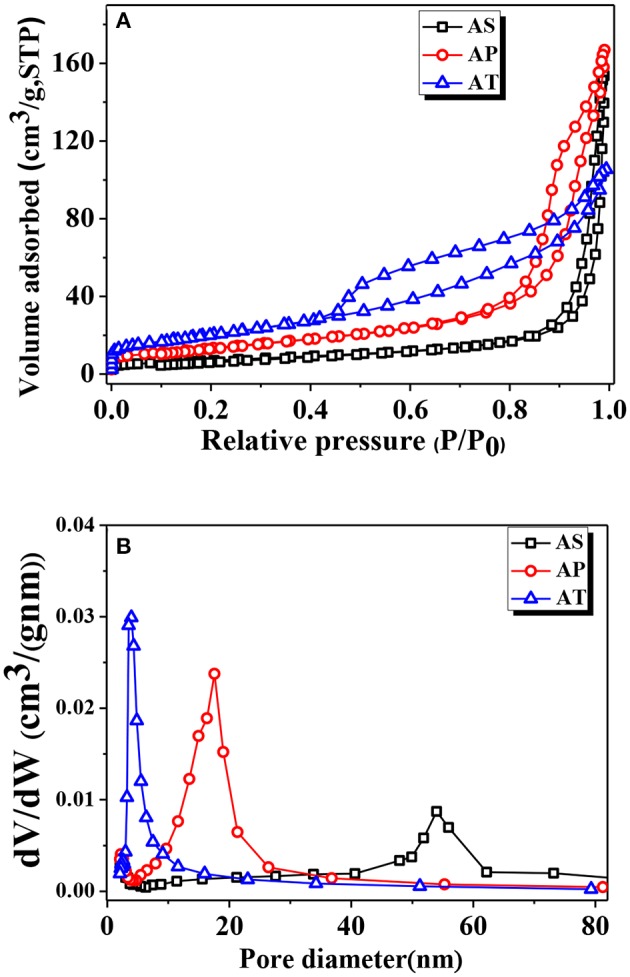
(A) Nitrogen adsorption–desorption isotherms and (B) pore size distributions [Barrett, Joyner, and Halenda (BJH) desorption] of Ag2O-TiO2 nanosphere (AS), Ag2O-TiO2 nanoplate (AP), and Ag2O-TiO2 nanotube (AT) samples.